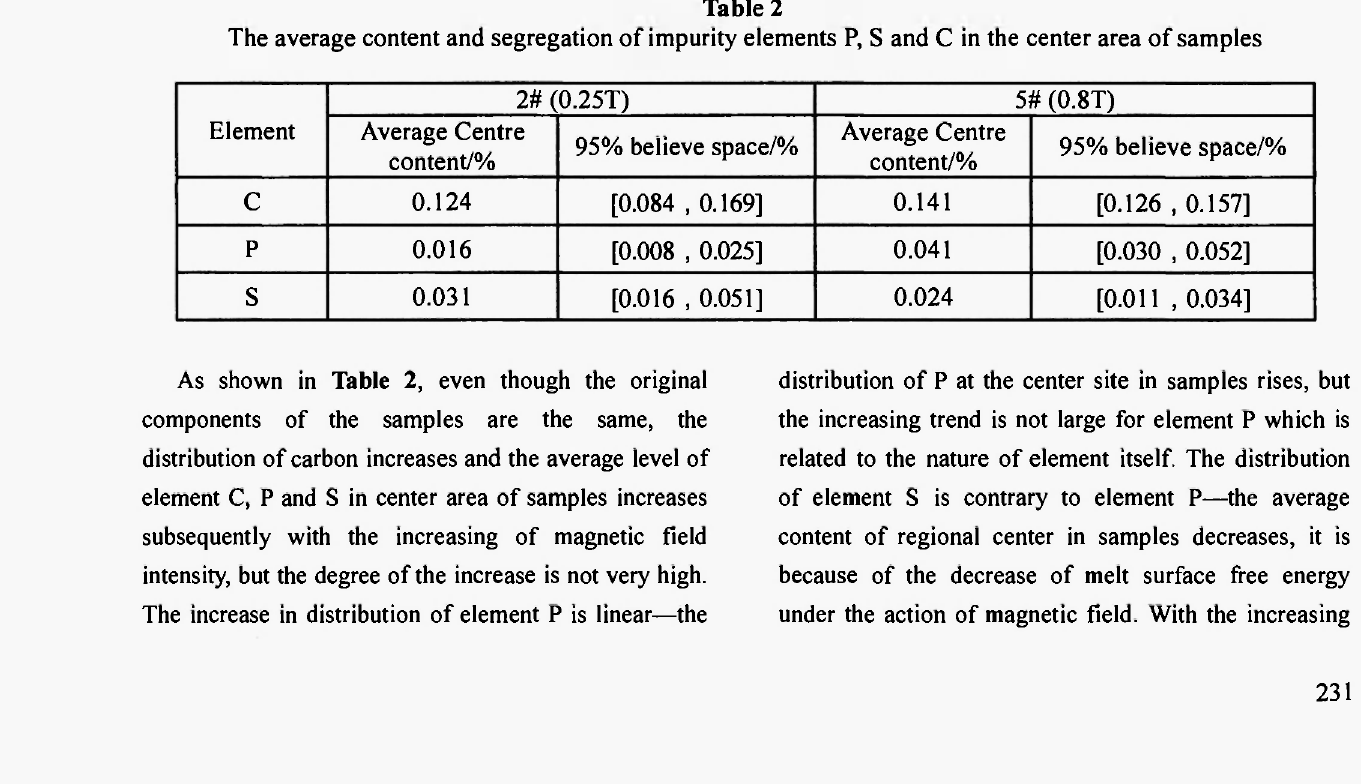
3.S The impact of magnetic field induce the element content at the bottom center of the samples change The samples processed by magnetic fields of 0.25T and 0.8T were analysed respectively by ΟΡΑ, the uneven—a corresponding data are shown in Table